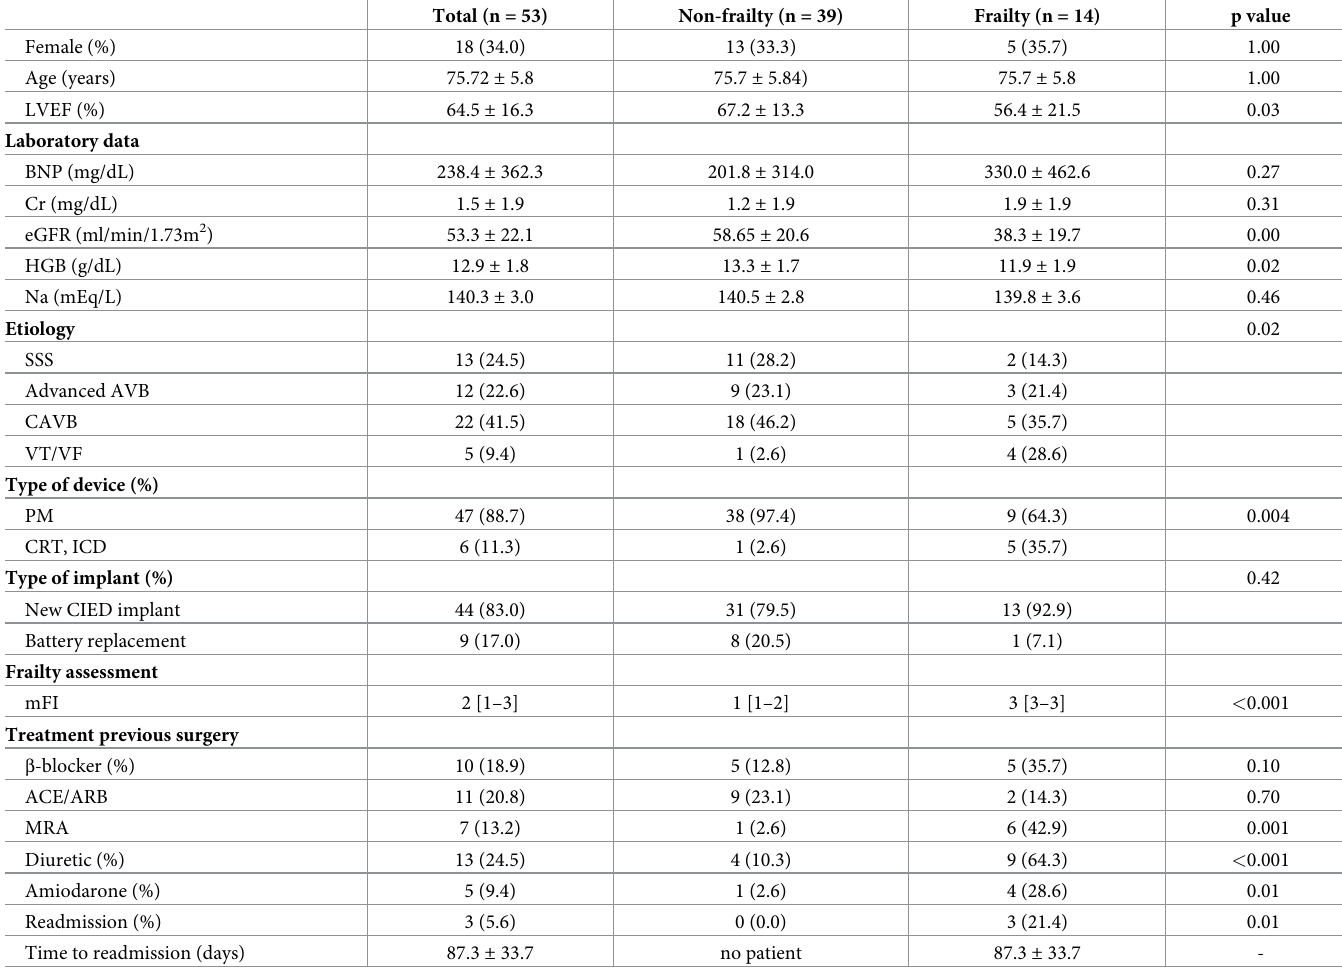
Table 5. Characteristics of participants without heart